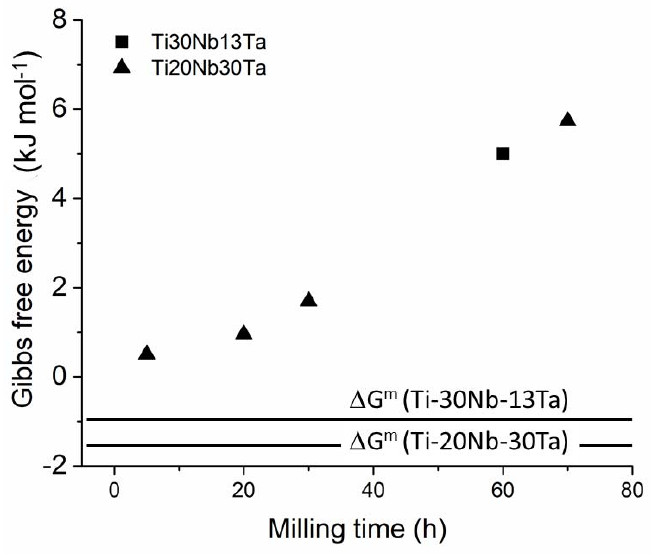
Figure 8. Evolution of Gibbs free energy as a function of milling time for the Ti-30Nb-13Ta alloy and the Ti-20Nb-30Ta alloy.